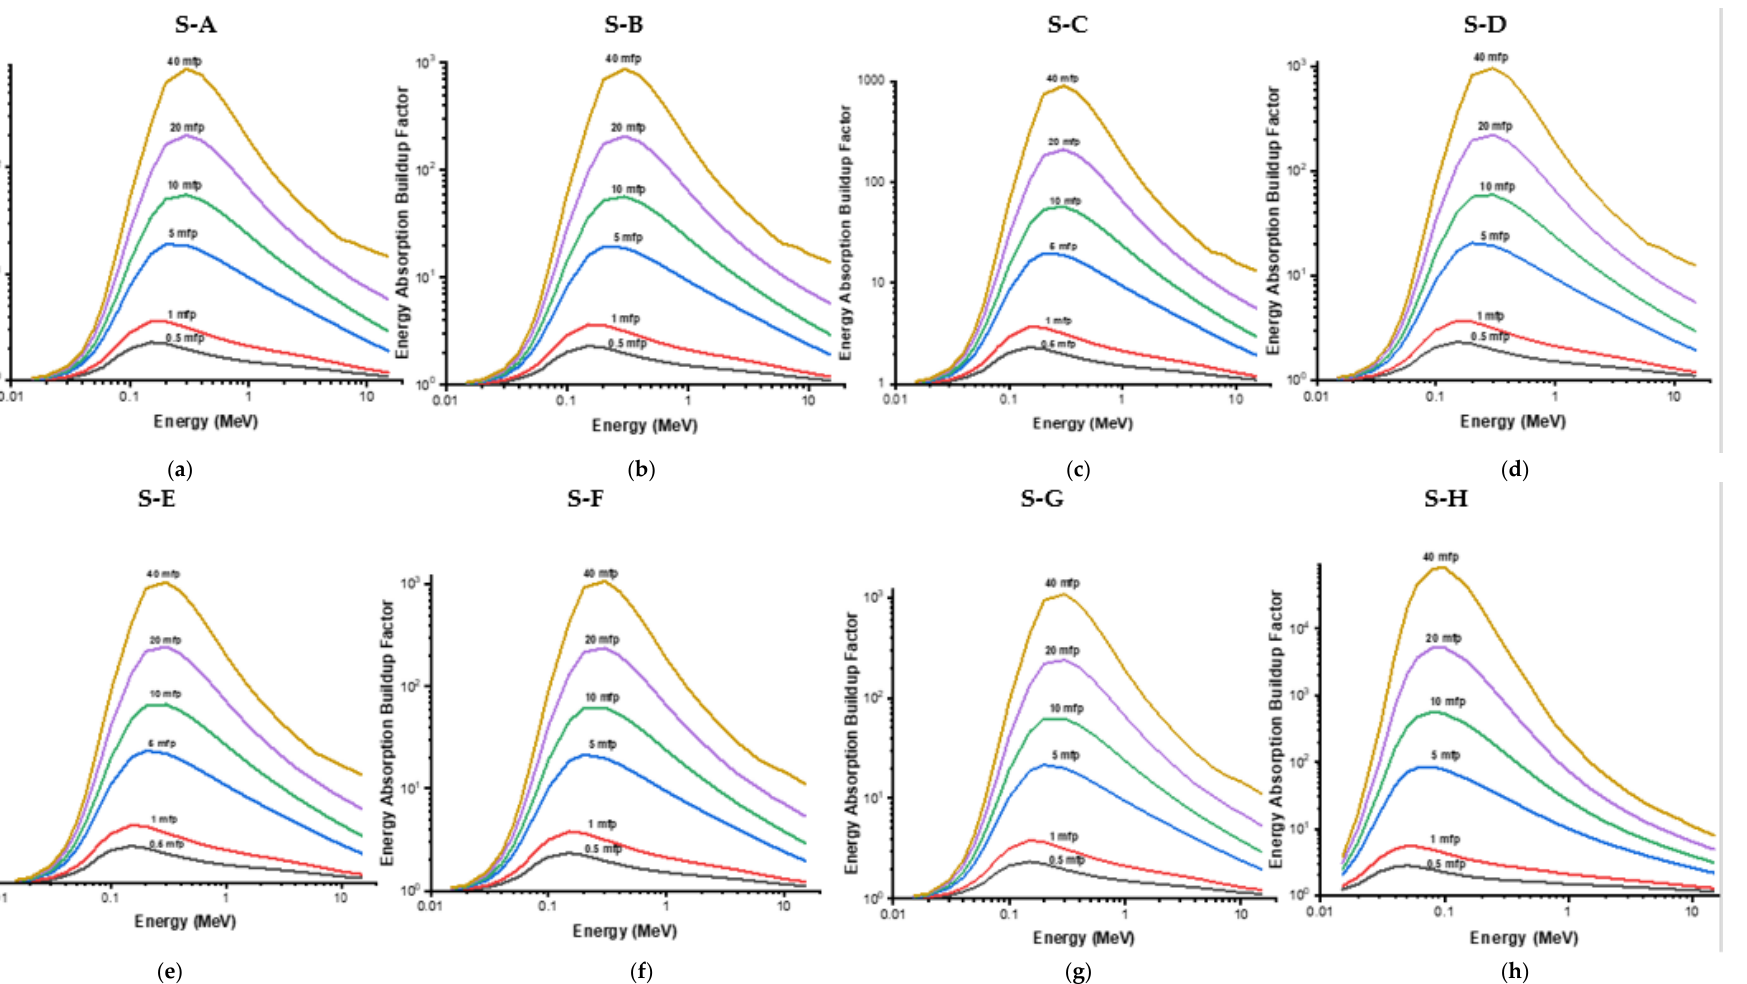
Figure 4. EABF of Sample A, B, C, D, E, F, G and H, respectively for range 0.015–15 MeV at different.( a ) is S-A, ( b ) is S-B, ( c ) is S-C, ( d ) is S-D, ( e ) is S-E, ( f ) is S-F, ( g ) is S-G and ( h ) is S-H.